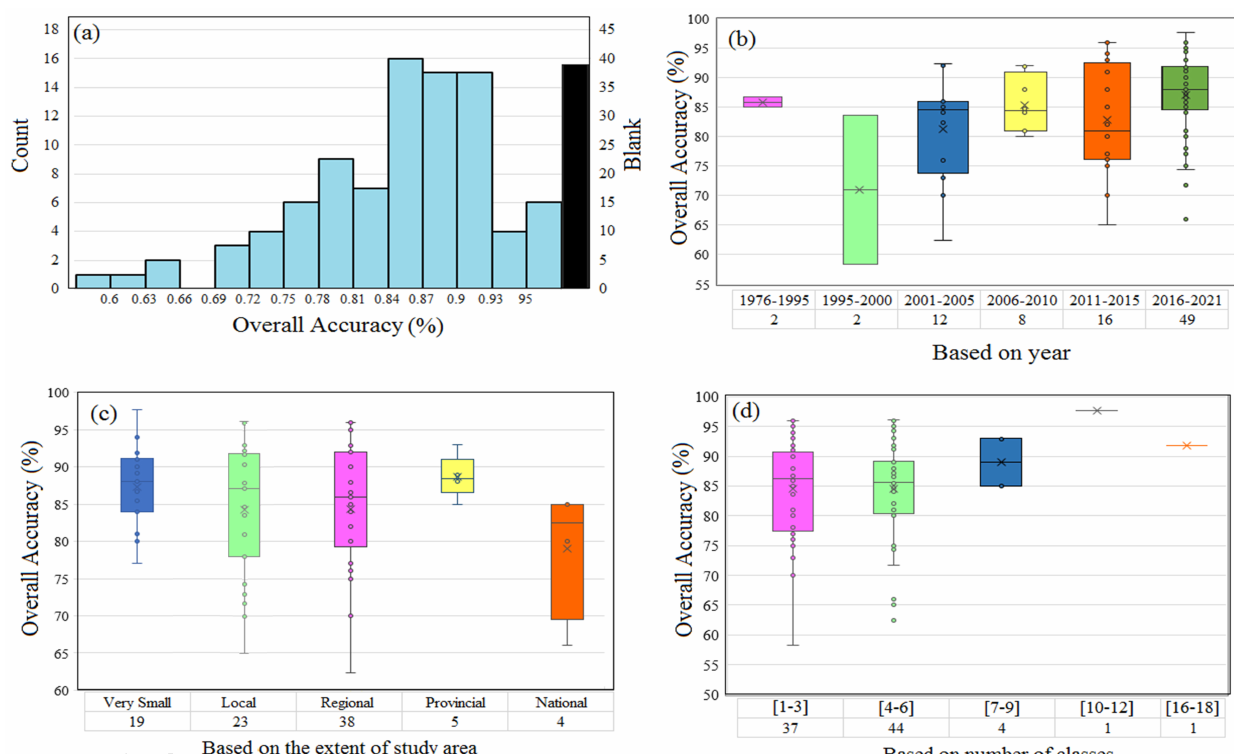
Figure 17. Overall accuracies reported in in RS-based wetland classification studies in Canada based on ( a ) the number of papers, ( b ) the year of publications, ( c ) the extent of study area, and ( d ) the number of classes considered in the classification